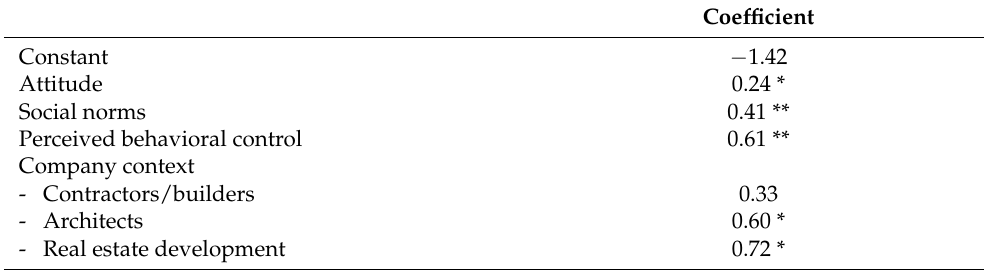
Table 7. Predictors of behavioral intention to use NID, including company